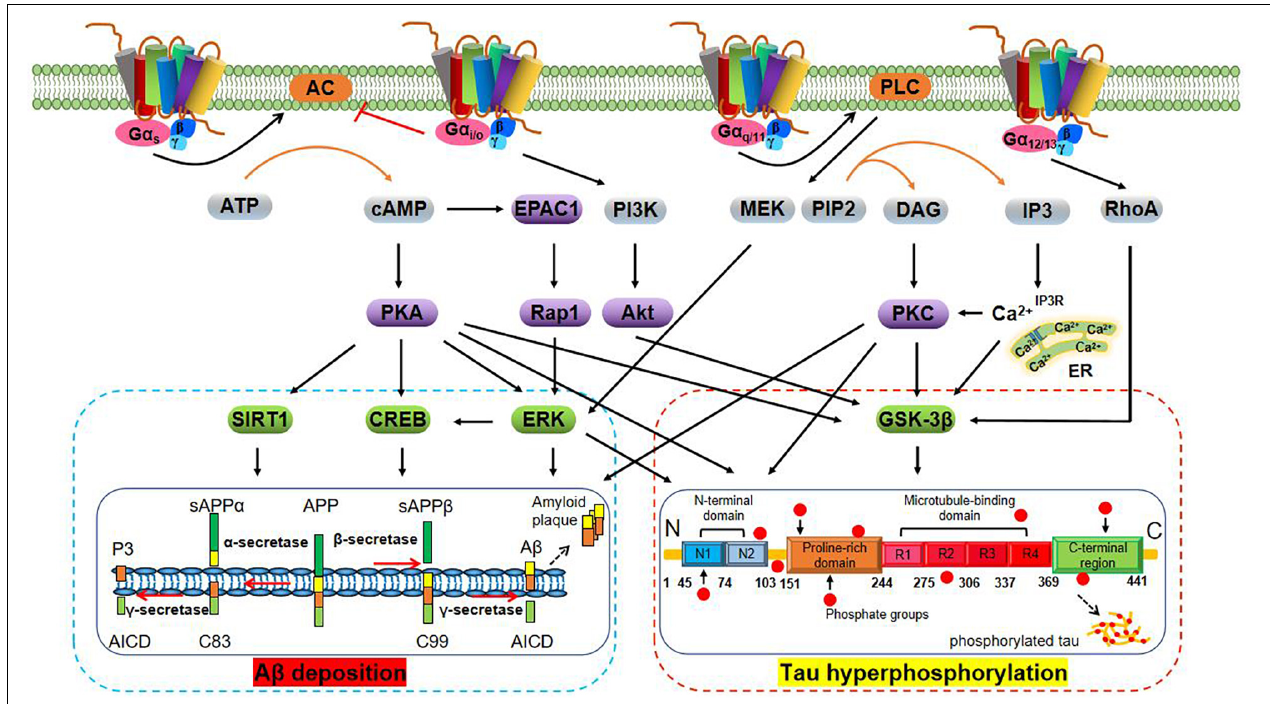
FIGURE 1 | Schematic representation of G protein regulation of A β deposition and tau hyperphosphorylation-related signaling pathways. A β is derived from the amyloidogenic cleavage of the transmembrane amyloid precursor protein (APP) mediated by α -, β -, and γ -secretases. In the amyloidogenic pathway, APP is first cleaved by the β -secretase (BACE-1), which generates soluble amyloid precursor protein β (sAPP β ) and the β -C-terminal fragment ( β -CTF, also termed C99). The latter is cleaved by γ -secretase to generate the A β peptide and the amyloid intracellular domain (AICD). The A β peptide aggregates to form A β oligomers (oA β ) and extracellular amyloid plaques (Hamm et al., 2017). In the non-amyloidogenic pathway, cleavage of APP by α -secretases [especially A disintegrin and metalloprotease 9 (ADAM9), ADAM10, and ADAM17] generates sAPP α and carboxy-terminal fragment termed C83. Subsequent cleavage of C83 by the γ -secretase complex yields the AICD and a short fragment termed P3 (De Strooper, 2010). Tau is an axonal protein expressed in mature neurons that promotes the self-assembly of tubulin into microtubules and its stabilization. The physiological function of tau depends on its phosphorylation status and is regulated by tau protein kinase and phosphatase. In AD brains, tau hyperphosphorylation under the abnormal regulation of protein kinases [e.g., glycogen synthase kinase-3 β (GSK-3 β )] results in the formation of NFTs (Congdon and Sigurdsson, 2018). Activation of G α s protein activates adenylyl cyclase (AC) and promotes cyclic adenosine monophosphate (cAMP) generation. cAMP regulates A β deposition and tau hyperphosphorylation via activation of the extracellular regulated protein kinase (ERK) (Angulo et al., 2003), cAMP-response element binding protein (CREB) (Wang Z. et al., 2018), silent mating type information regulation 2 homolog 1 (SIRT1), and GSK3 β interaction protein/GSK3 (Ko et al., 2019; Zhang Z. et al., 2020) signaling pathways in a protein kinase A (PKA)-dependent manner (Lebel et al., 2009), and exchange protein directly activated by cAMP 1 (EPAC1)/Rap1 in a PKA-independent manner (Maillet et al., 2003). By contrast, activation of G α i / o protein inhibits the cAMP/PKA pathway. Activation of G βγ protein may regulate tau phosphorylation through phosphatidylinositol 3-kinase (PI3K)/protein kinase B (PKB, also termed Akt)/GSK-3 β pathway (Wang et al., 2016). Activation of G α q / 11 protein activates phospholipase C (PLC) to produce inositol trisphosphate (IP3) and diacylglycerol (DAG), which in turn increases